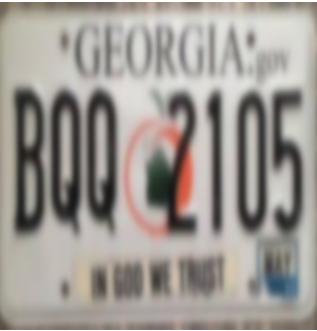
Figure 23. Image used for a comparison between AAP- and EG-based ICA learning systems. Such colored image was turned into a grey-level image by extracting the first channel from its RGB